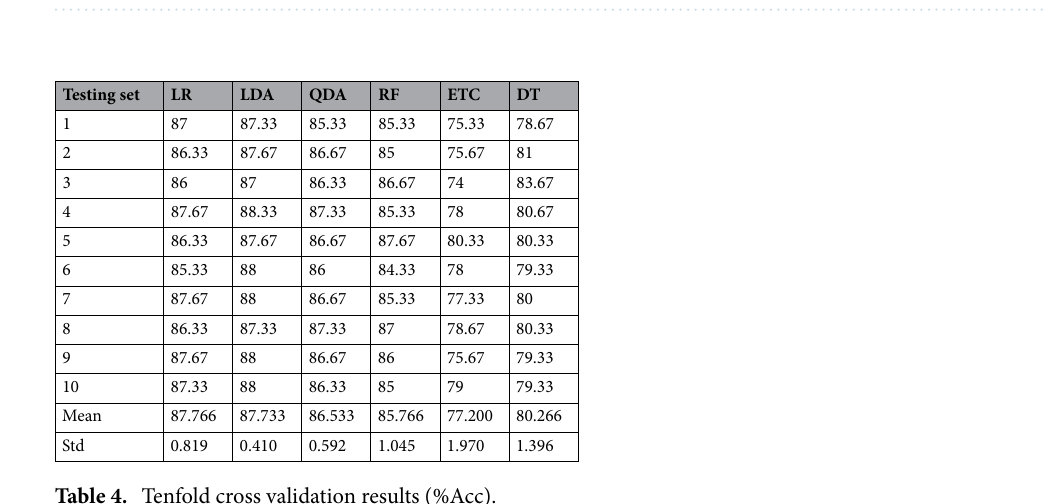
Figure 3. LR confusion matrix.